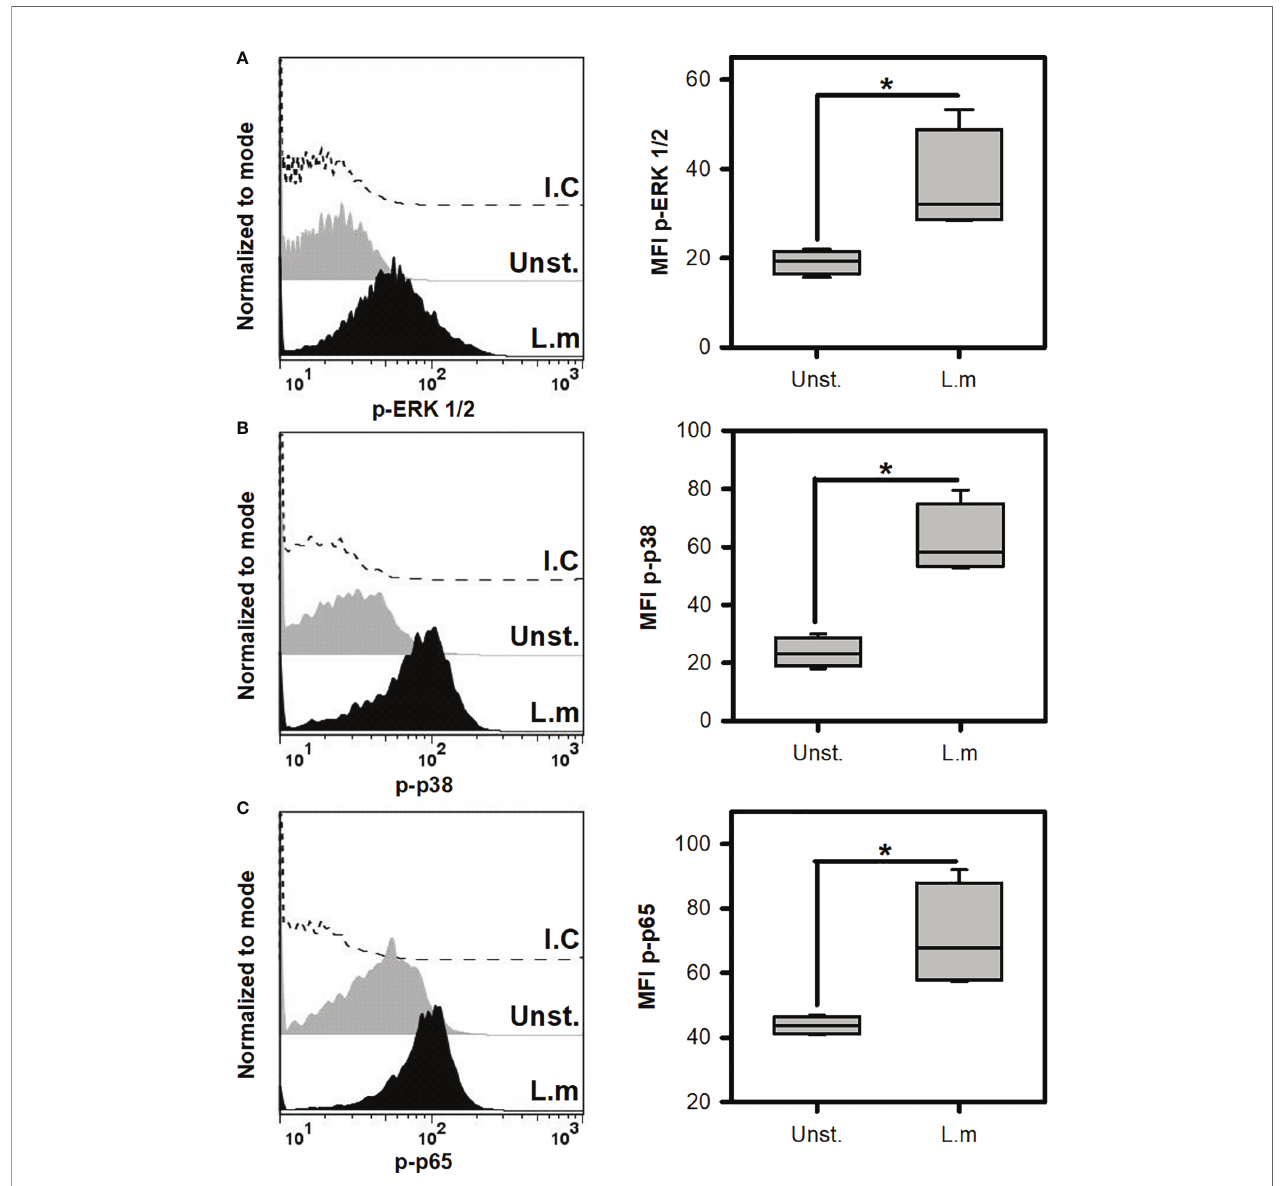
FIGURE 3 | Listeria monocytogenes induce the phosphorylation of cell signaling proteins involved in TLR activation in mast cells. 2.5x10 5 BMMC/0.25 mL of complete medium were stimulated with L.m at MOI 100:1 for different times to determine the phosphorylation of (A) ERK 1/2 at 15 minutes, (B) p38 at 60 minutes and (C) p65 at 30 minutes by fl ow cytometry. The graphs show the median fl uorescence intensity (MFI). (Sum of 4 independent experiments, n=4 per group and for each phospho-protein. *p<0.05; Mann-Whitney